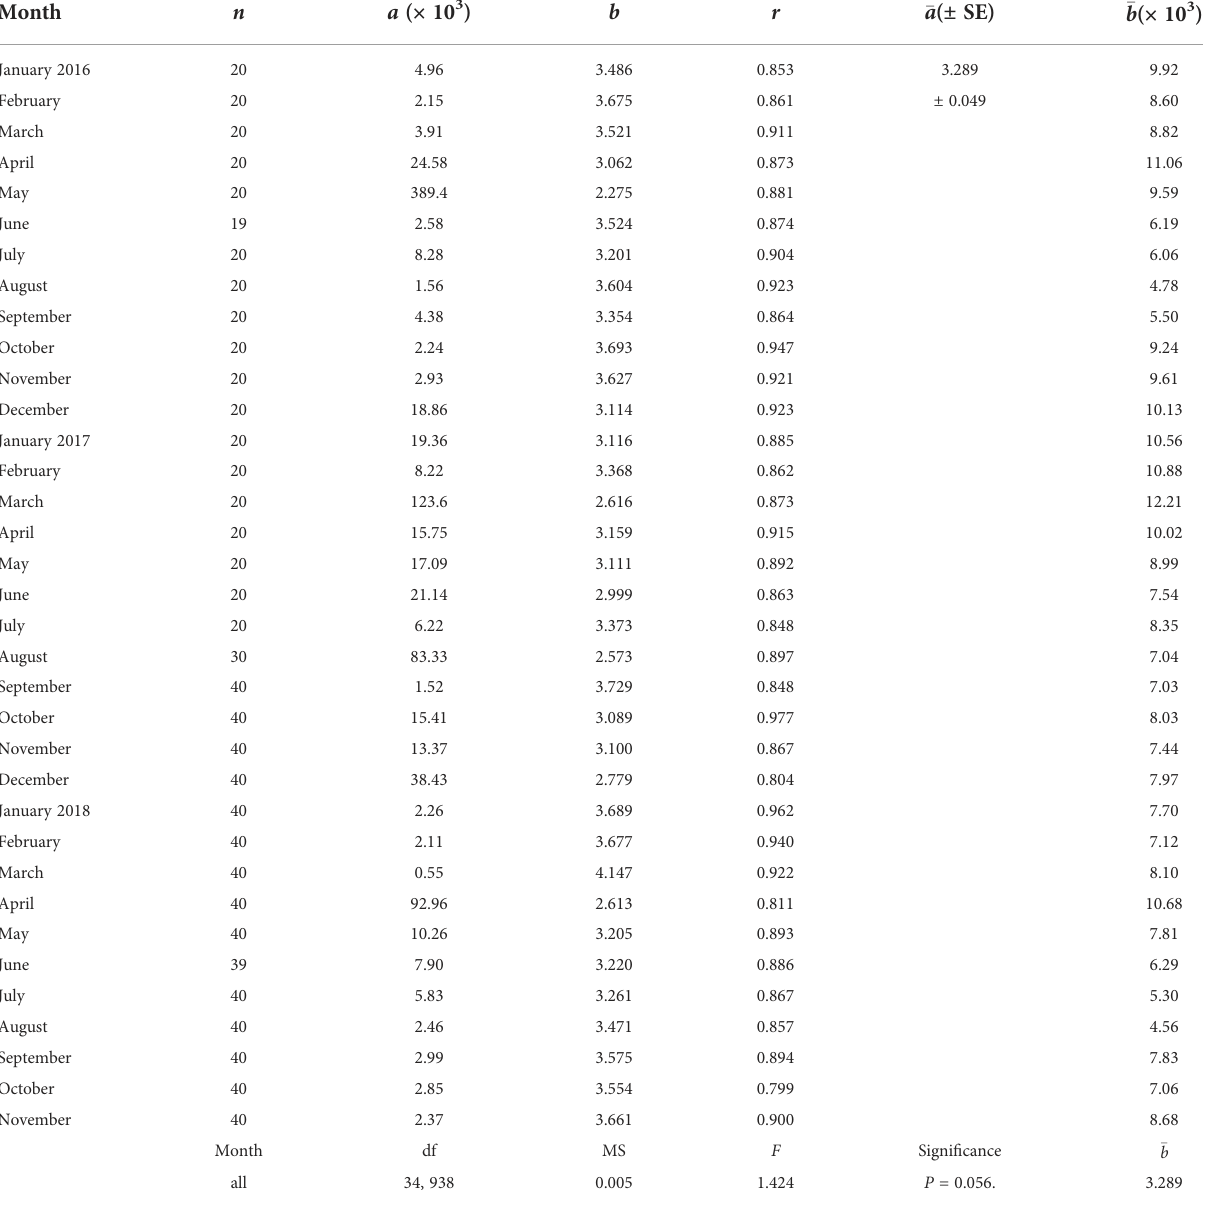
TABLE 3 Regression coef fi cients of allometric equation W = aL b between shell length (L, mm) and dry fl esh weight (W, mg) of the ark shell Anadara kagoshimensis . a and b indicate estimates of regression intercept and slope (exponent), respectively. Month n a (× 10 3